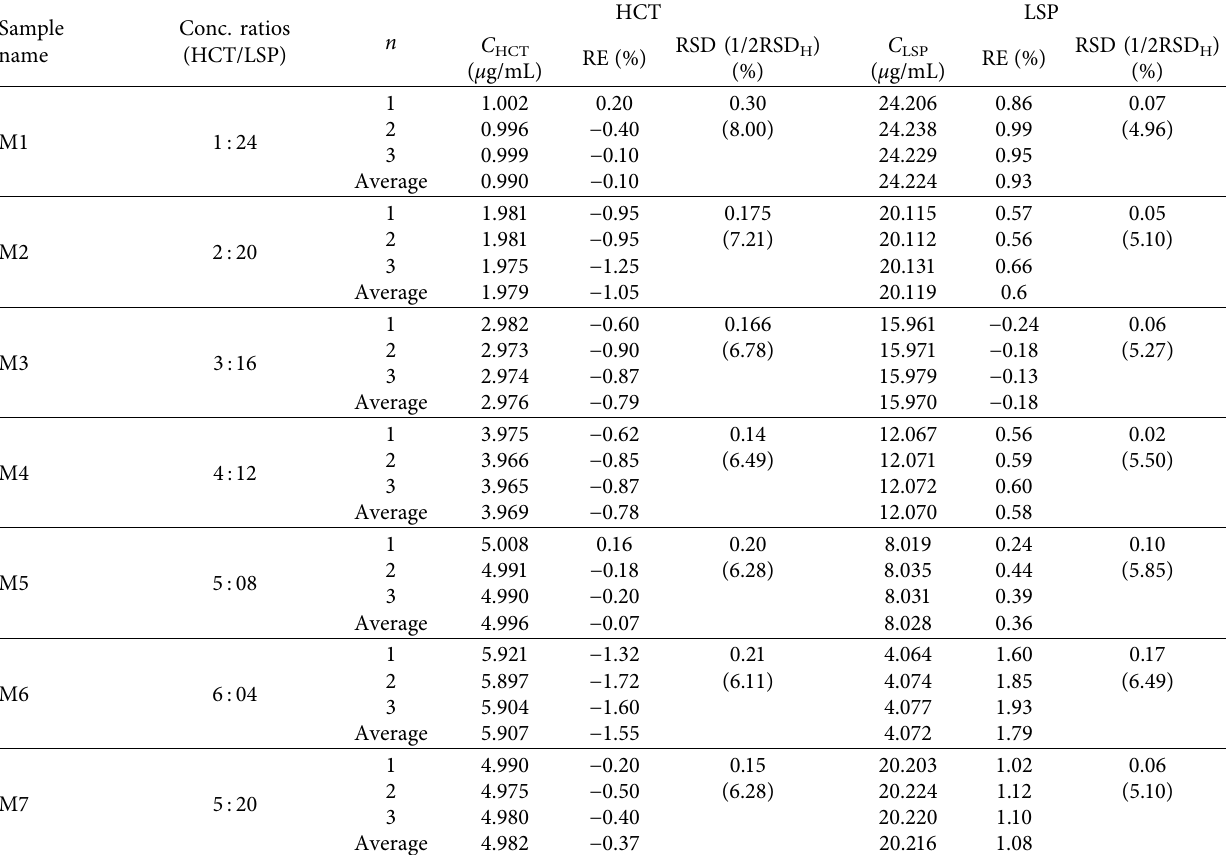
Table 1: Relative errors and repeatability of the Kalman-Excel method. Sample